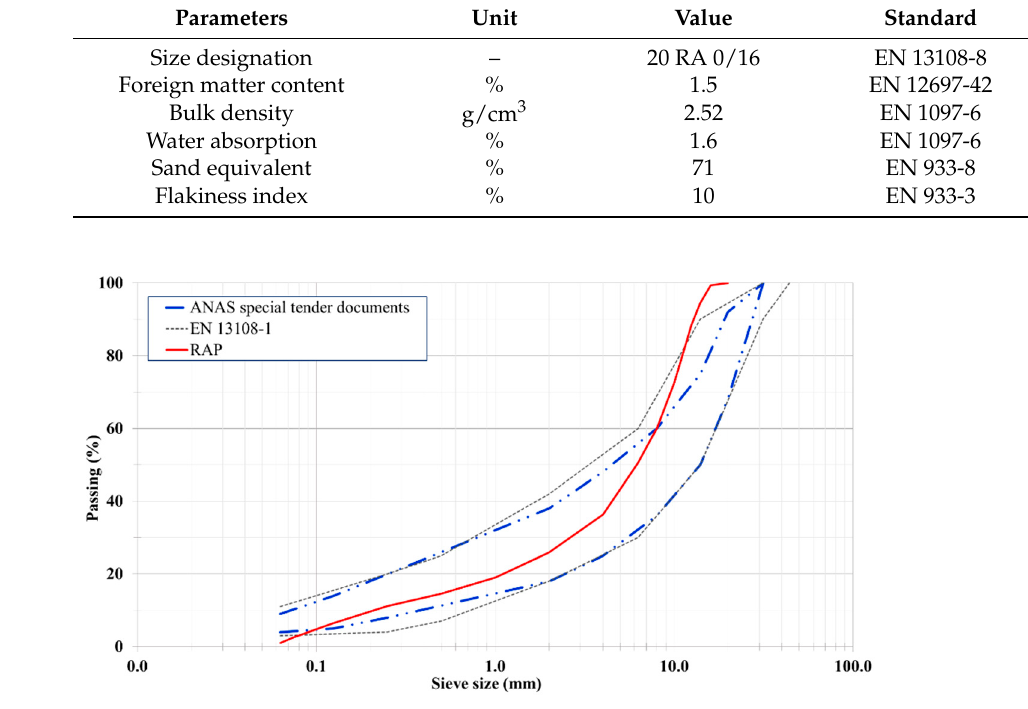
Figure 3. Grading curve of RAP according to standard requirements.